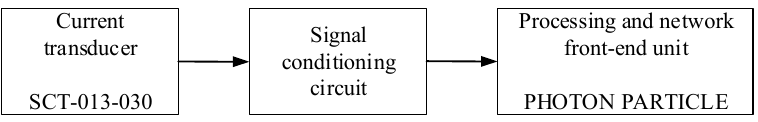
Figure 1. The main parts of the proposed IoT system.